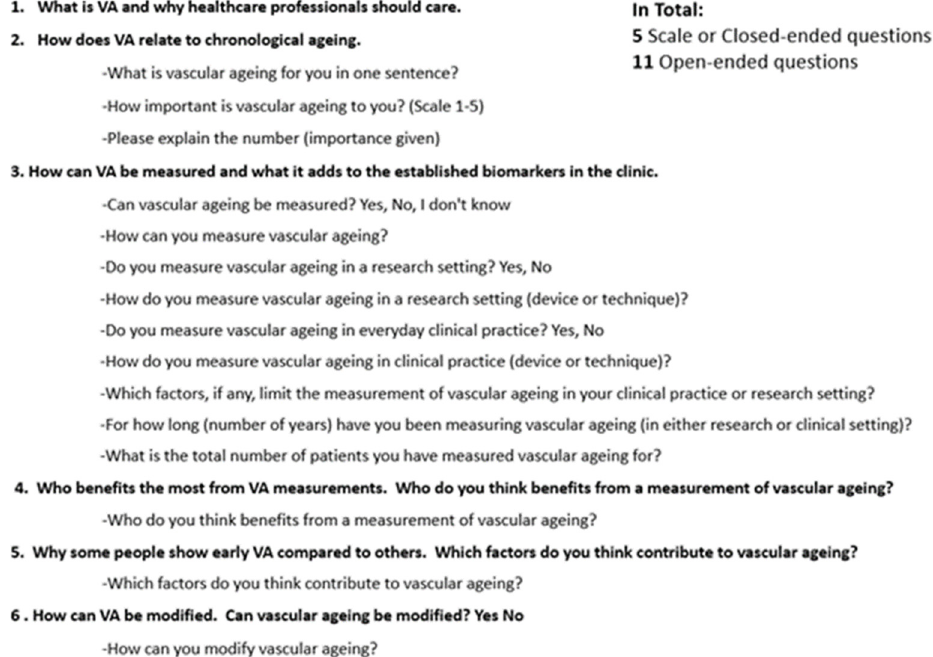
Figure 2. Development of the SSQ from the six main topics.